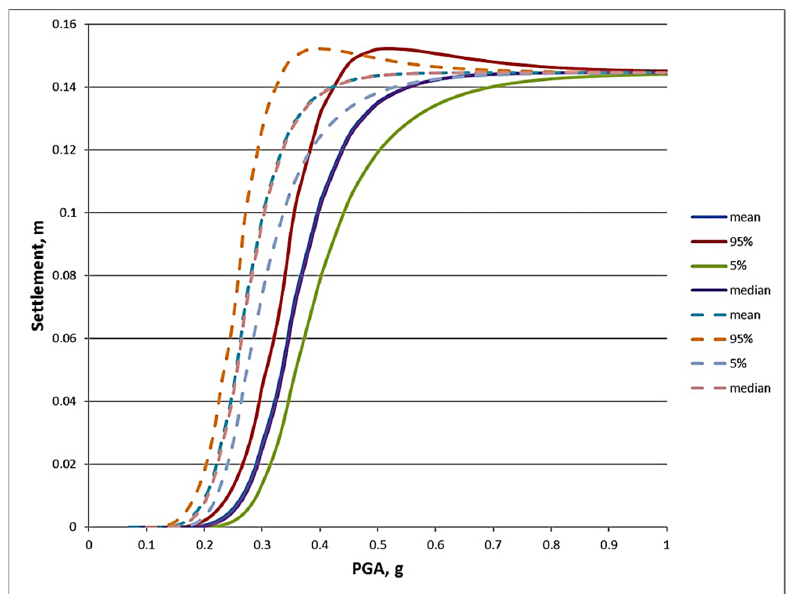
Figure 8. Loaded by the main building (dashed line) and unloaded, free field (solid line) settlements versus peak ground acceleration at the critical section of the emergency service water piping.